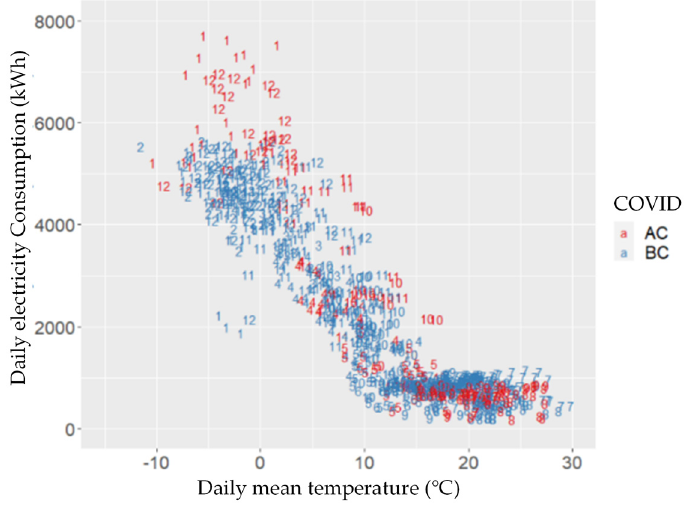
Figure 11. Relationship between daily energy consumption and outdoor temperature at Junior High School C.